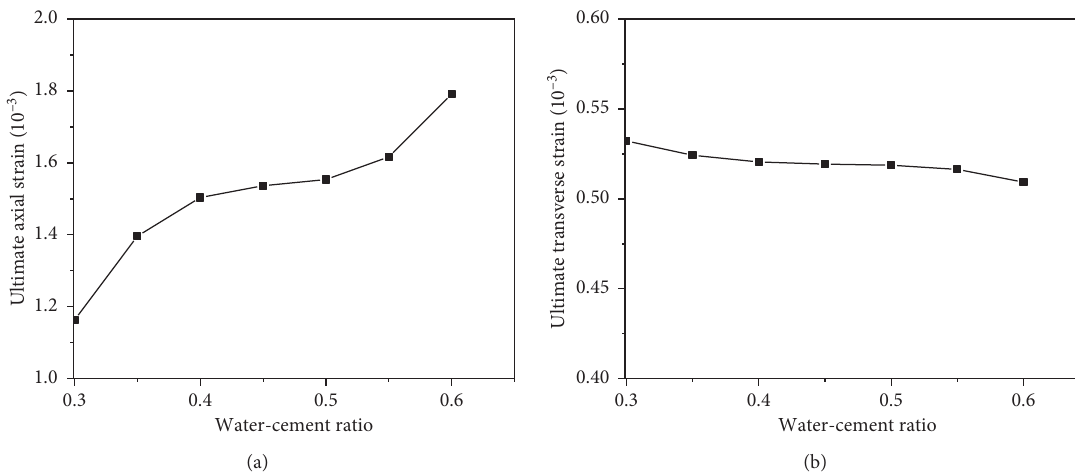
Figure 21: The impact of the water-cement ratio on the ultimate strains of the FSSAC stub columns. (a) Ultimate axial strain. (b) Ultimate transverse strain.